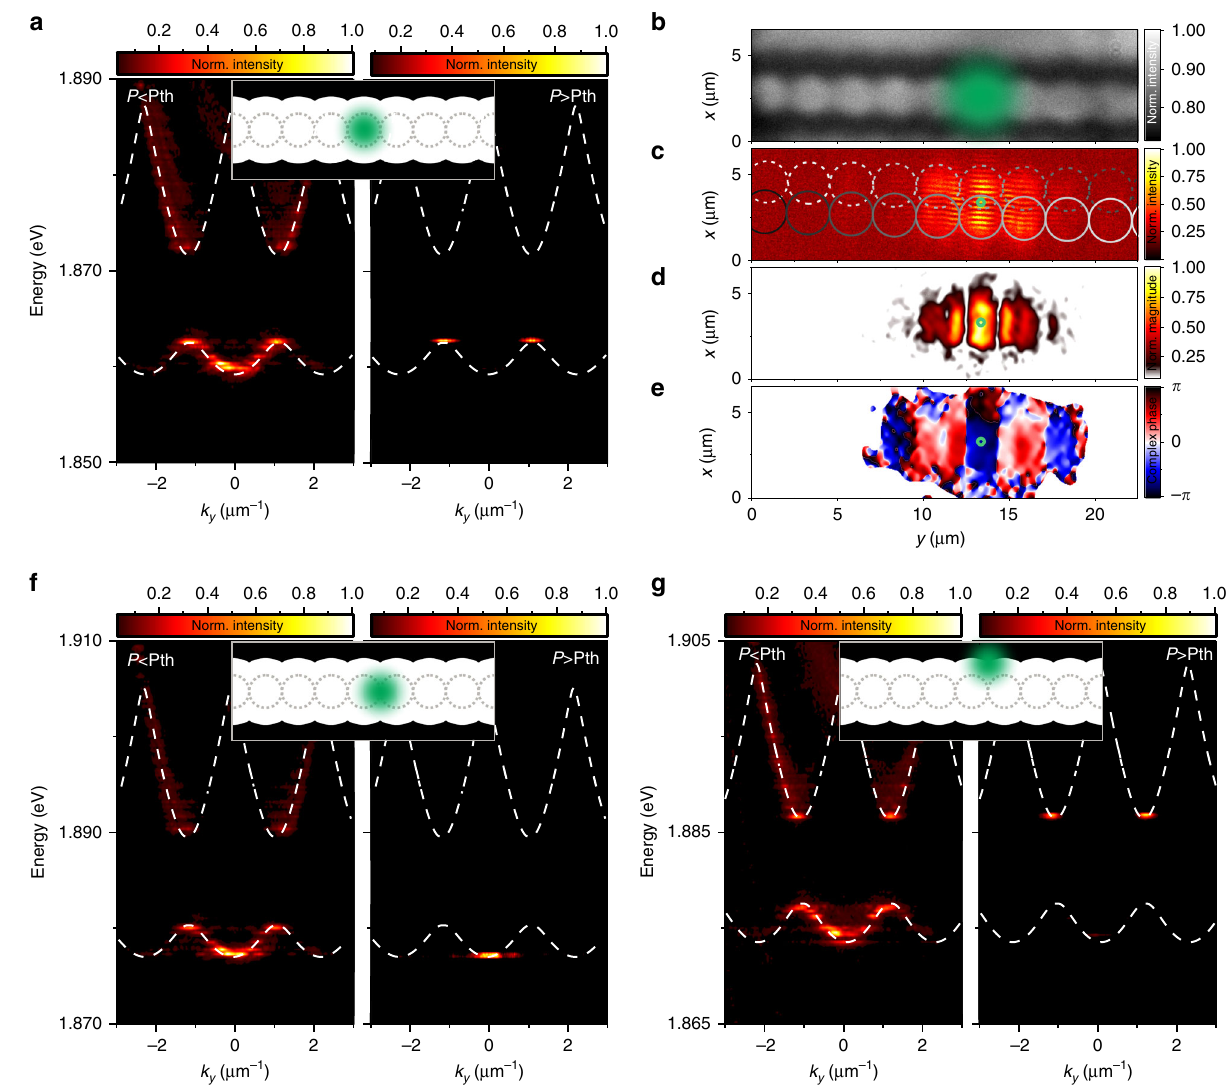
Fig. 3 Controlled loading of the polariton condensate in the lattice. Off-site versus on-site pumping and formation of corresponding gap-state condensates. a , f , g Far- fi eld spectra below (left) and above (right) the condensation threshold, corresponding with the pump-potential alignment inserted with a sketch of the position of the pump laser spot (green) aligned with respect to the polariton potential. White lines show calculated single-particle energy bands. b Microscope image of the investigated device, indicating the positioning of the pump spot for on-site pumping. c Spatial coherence measurement under on-site excitation above threshold. d Extracted coherent magnitude and e phase of the condensate in the lattice. The centro- symmetric mirror point is indicated with a green circle in c – e